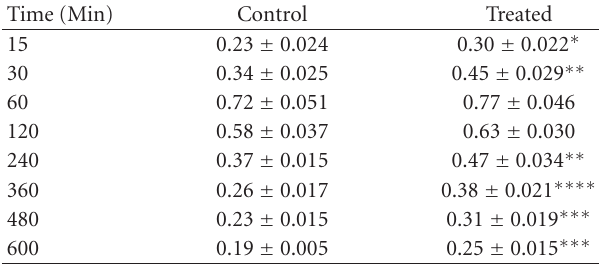
Table 8: Comparison of mean plasma levels of oxytetracycline ( μ g/mL) at di ff erent time intervals following oral administration in control and P. longum- treated WLH birds [91].